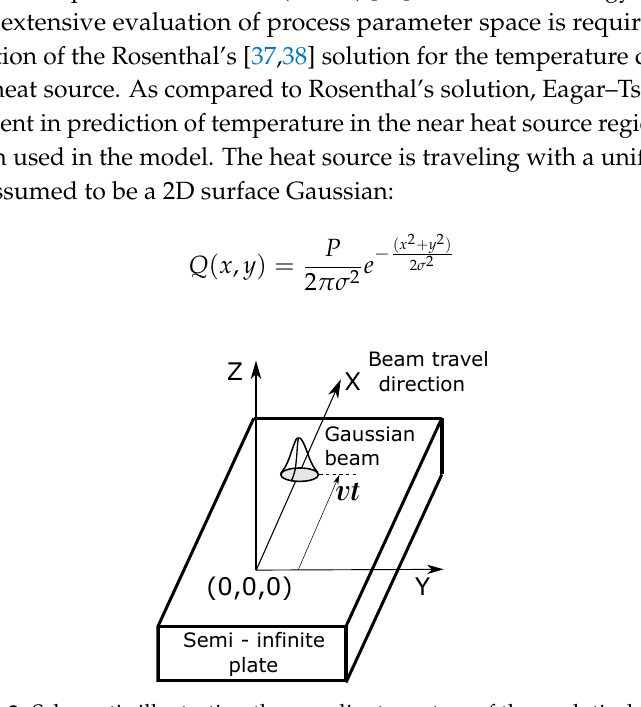
Figure 2. Schematic illustrating the coordinate system of the analytical